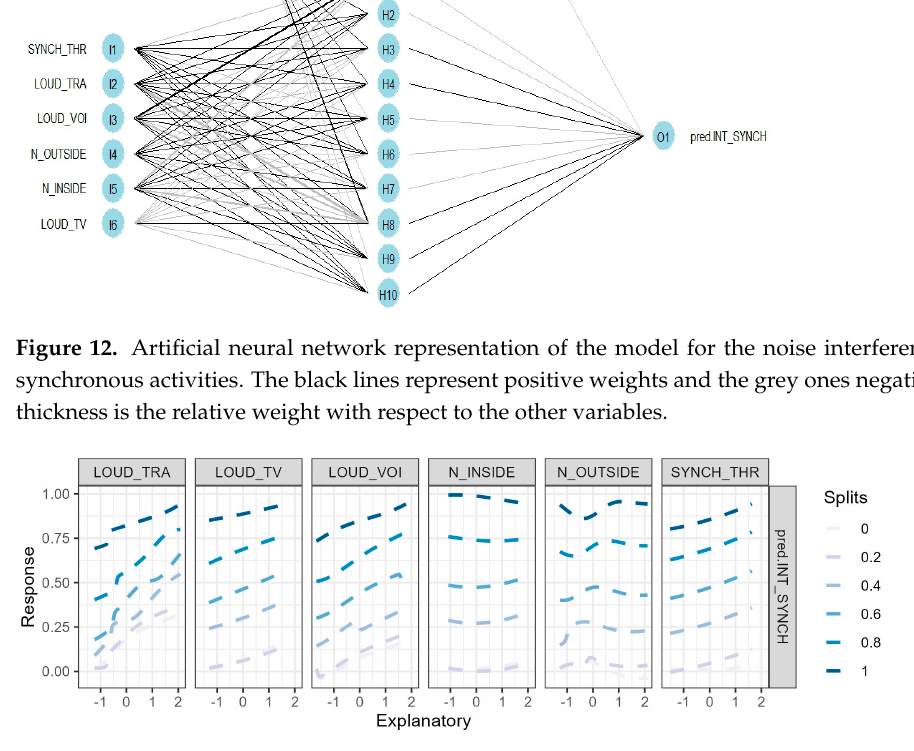
Figure 13. Profile method applied to the ANN model of the noise interference with synchronous activities, using as input variables the ones selected by the mRMR method. The predicted variable is split into quantiles.